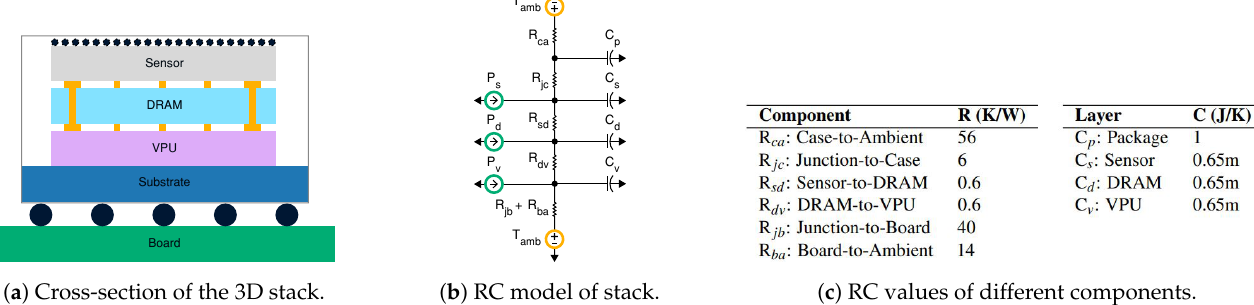
Figure 2. Using the well-known duality between thermal and electrical phenomena, thermal modeling of stacked sensors can be performed by analyzing an equivalent RC